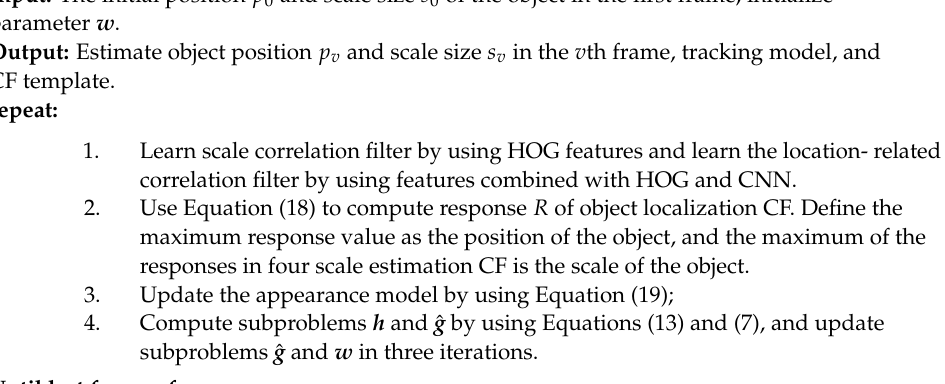
Algorithm 1. The proposed ASTCF